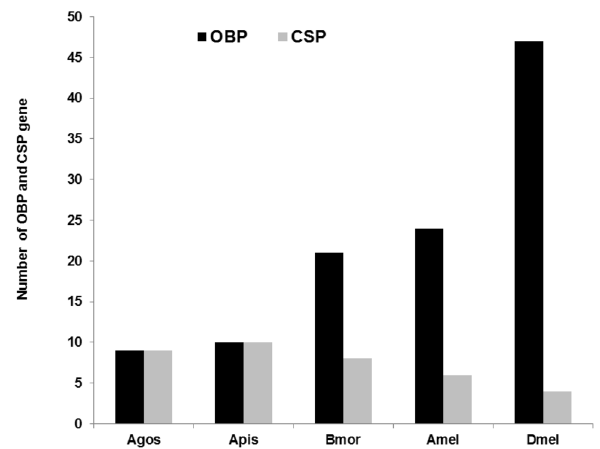
Figure 4. Number of annotated OBP and CSP genes in insect genomes. Agos: Aphis gossypii . Apis: Acyrthosiphon pisum . Bmor: Bombyx mori . Amel: Apis mellifera . Dmel: Drosophila melanogaster .